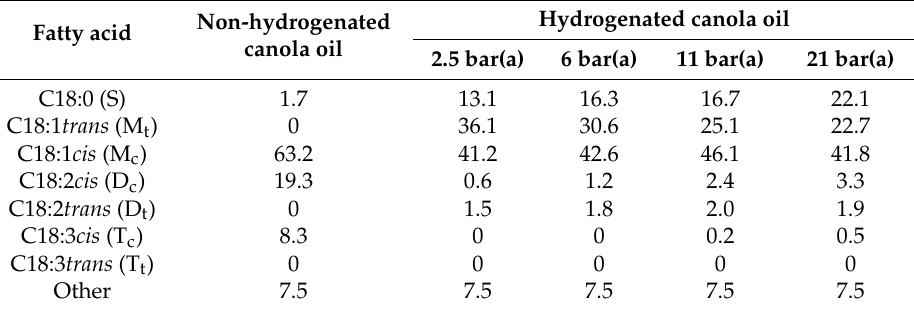
Table 3. Fatty acids content (%) in samples of canola oil hydrogenated on INS Ni_C catalyst (IV~70).